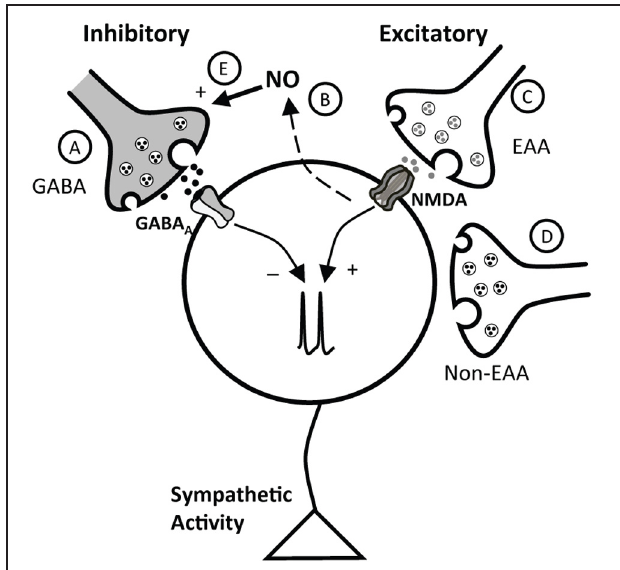
FIGURE 8 | Schematic representation of potential interactions of inhibitory and excitatory inputs to the PVN. The cell in the schematic represents a PVN neuron involved in control of sympathetic nervous system activity. As described in the text, this neuron receives inhibitory influences due to GABA, via GABA A receptors (A) , and NO (B) , which appears to exert its effects at least in part through GABA (E) . Excitatory inputs include both excitatory amino acid (EAA, C ) and non-ionotropic EAA receptor mediated (non-EAA) (D) inputs. NO, likely acting through GABA, both blunts the response to activation of NMDA receptors, and tonically inhibits the effects of ongoing EAA